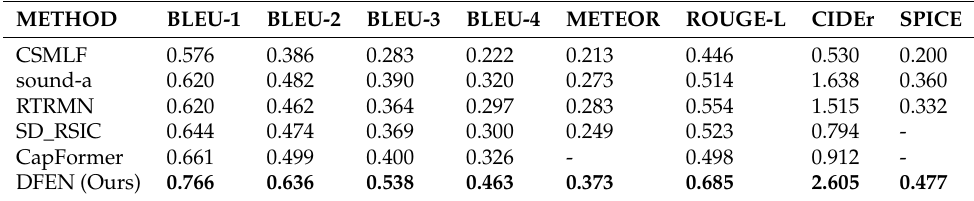
Table 3. Results of different models on the RSICD